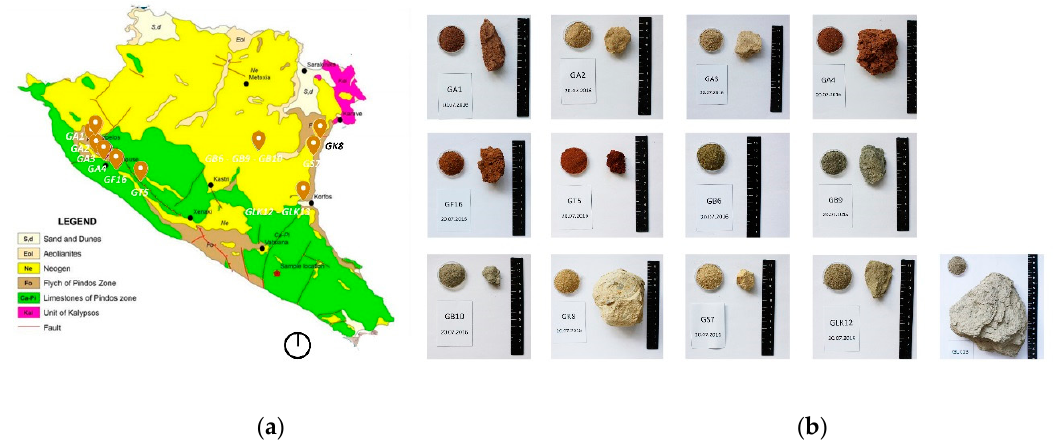
Figure 1. ( a ) Map of geologic formations of Gavdos [15]; sampling positions and ( b ) colour palette of the samples.